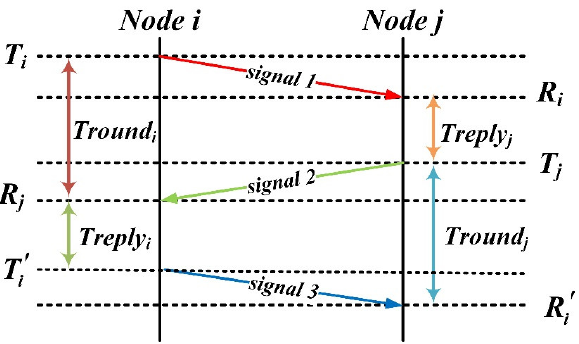
Figure 4. Node-to-node asymmetric double-sided two-way ranging measurement process.